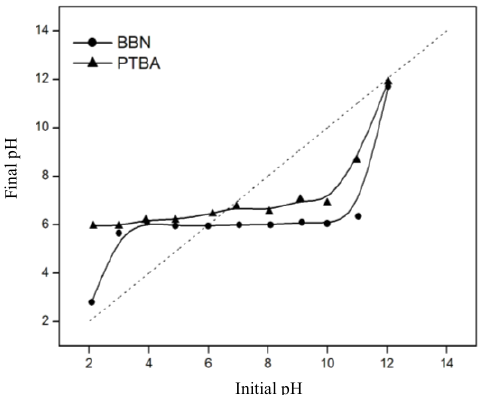
Initial Figure 7. Determination of point of zero charge of BBN and PTBA.